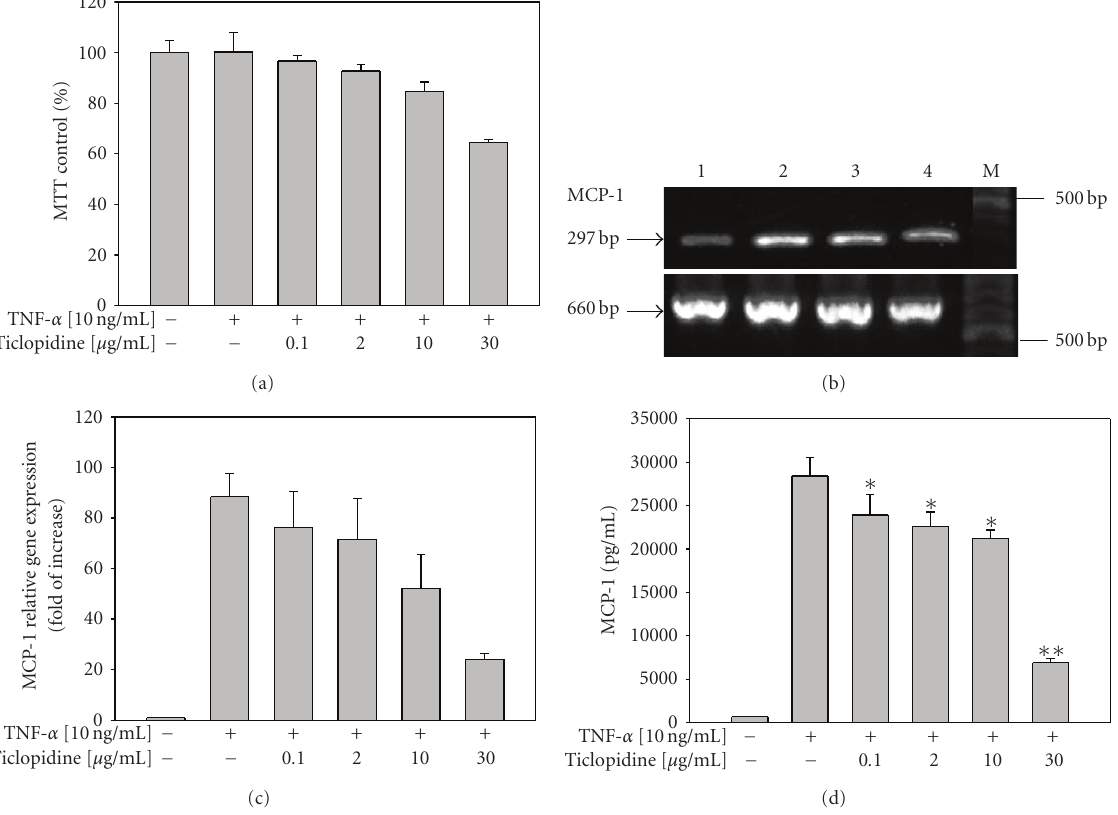
Figure 1: Reduction of MCP-1 mRNA and protein levels by ticlopidine in HUVECs. HUVECs were incubated with serum-free medium for 12hours before di ff erent concentrations of ticlopidine were added, after 12hours incubation cells were stimulated with/without TNF- α (10ng/mL) for another 24 hours. (a) Cell growth was analyzed by MTT. Results are mean ± SEM ( n = 3). (b) Total RNA was extracted and analyzed by RT-PCR. Lane 1, without TNF- α ; lane 2, TNF- α (10ng/mL) alone; lane 3, TNF- α + ticlopidine (0.1 μ g/mL); lane 4 TNF- α + ticlopidine (30 μ g/mL); M denotes molecular size marker. The lower panel is β -actin as internal control. Results are representative of one of three independent experiments. (c) Relative amount of MCP-1 mRNA level was determined by quantitative real-time RT-PCR. (d) Culture supernatants were analyzed by ELISA. Data are expressed as the mean ± SEM of duplicate wells and are representative of five individual experiments. Significantly di ff erent versus TNF-treated alone ∗ P < .05, ∗∗ P <